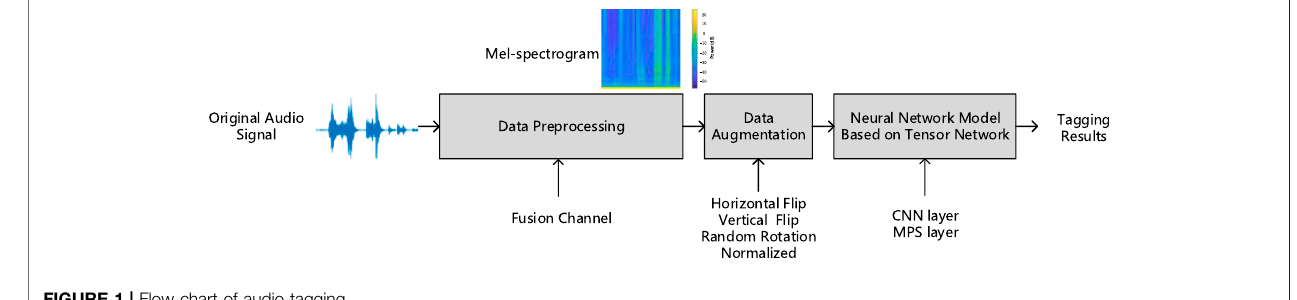
FIGURE 1 | Flow chart of audio tagging.